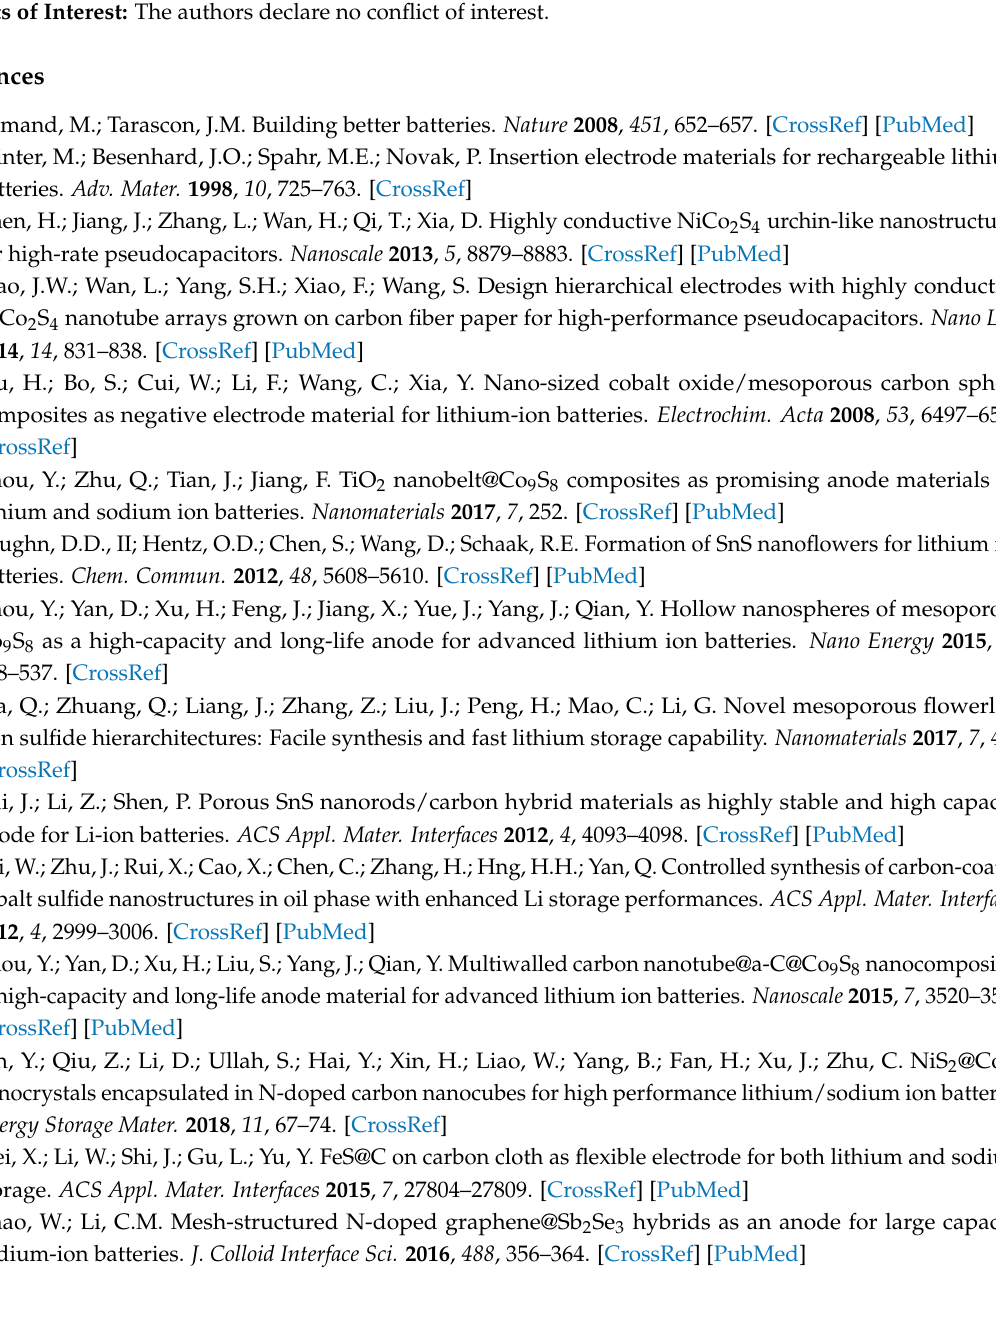
Figure S1: TG analysis of SnS@C composites, Figure S2: (a) XRD pattern and (b) TEM image of SnS